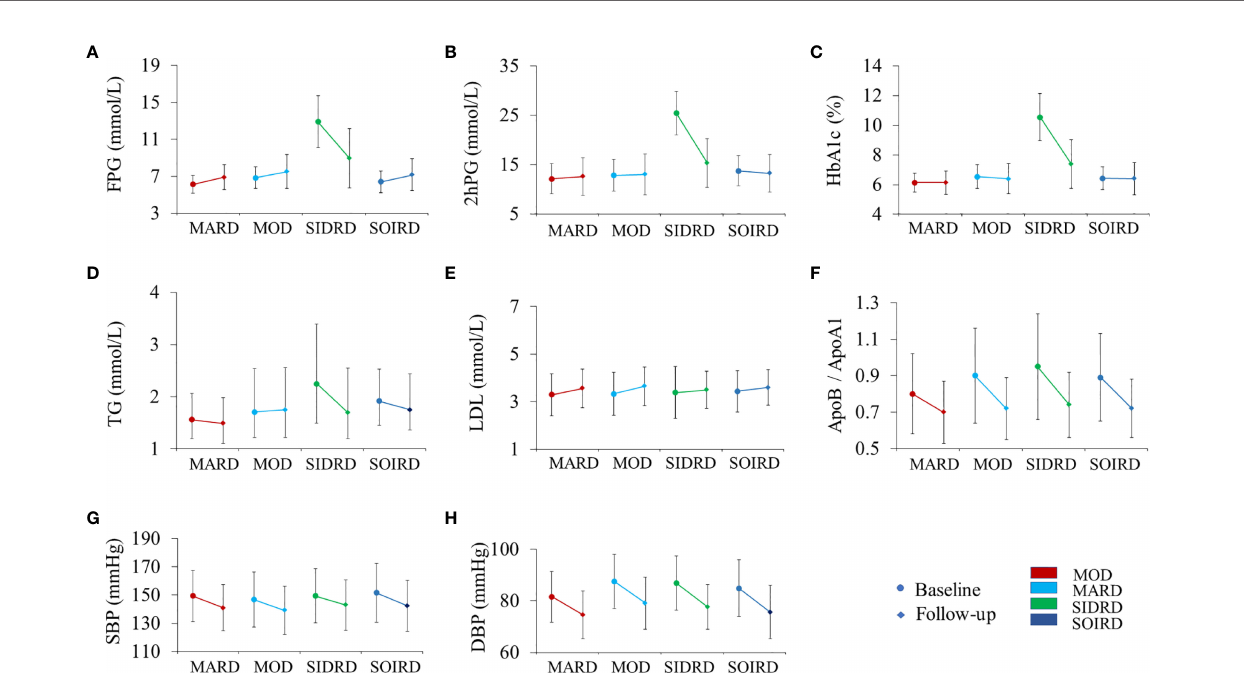
FIGURE 2 | Changes in the metabolic biomarkers during follow-up by clusters. Plots show levels of FPG (A) , 2hPG (B) , HbA1c (C) , TG (D) , LDL (E) , ApoB/ApoA1 (F) , SBP (G) , and DBP (H) . Levels are shown for patients with data available at both baseline (circles) and follow-up (diamond). Data are expressed as mean (SD) for variables with normal distribution or median (IQR) for variables with skewed distribution. P values for paired t-test between baseline and follow-up by clusters are presented in Supplementary Table 2 . MARD, mild age-related diabetes; MOD, mild obesity-related diabetes; SIDRD, severe insulin-de fi cient and insulin-resistant diabetes; SOIRD, severe obesity-related and insulin-resistant diabetes; FPG, fasting plasma glucose; 2hPG, 2 hours postprandial blood glucose; HbA1c, hemoglobin A1c; TG, triglyceride; LDL, low density lipoprotein; ApoB, apolipoprotein B; ApoA1, apolipoprotein A1; SBP, systolic blood pressure; DBP, diastolic blood